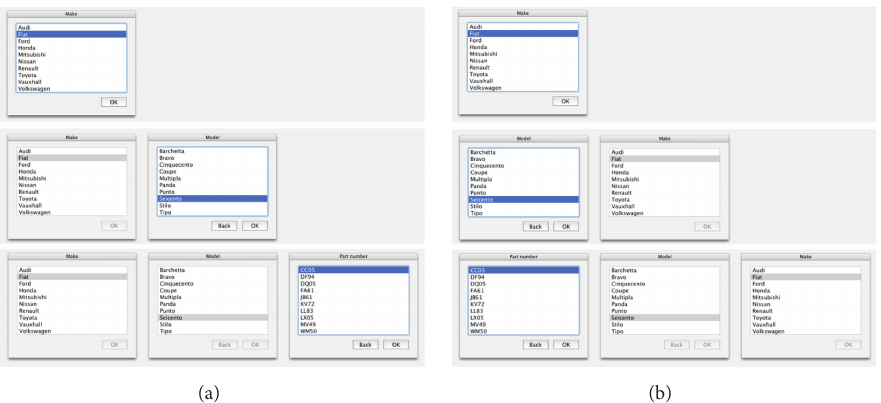
Figure 1: Three successive screens from an interaction with the car-parts database in experiment 1, with the translated interface on (a) and the collocated interface on (b).